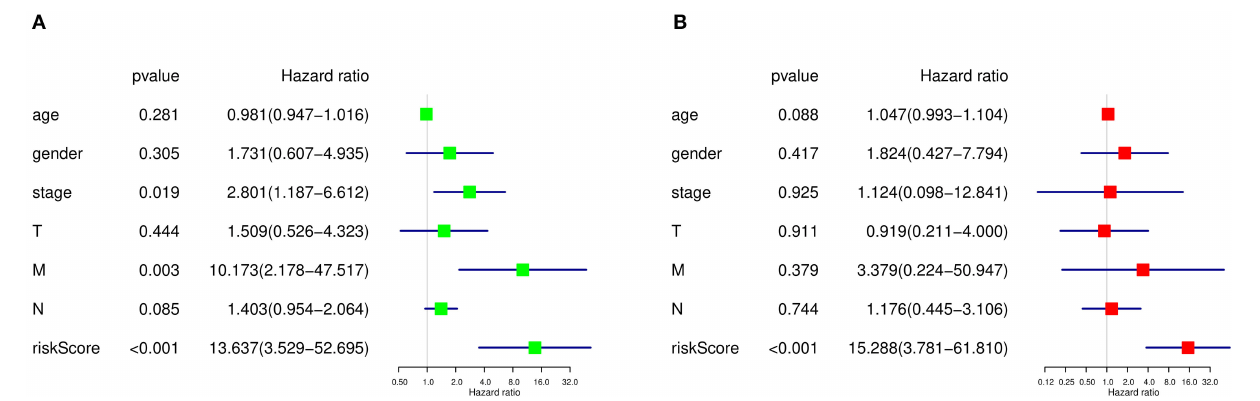
FIGURE 9 | Cox regression analysis of prognosis-related clinical features and OS-ASEs . (A) Univariate Cox regression analysis and (B) multivariate Cox regression analysis.